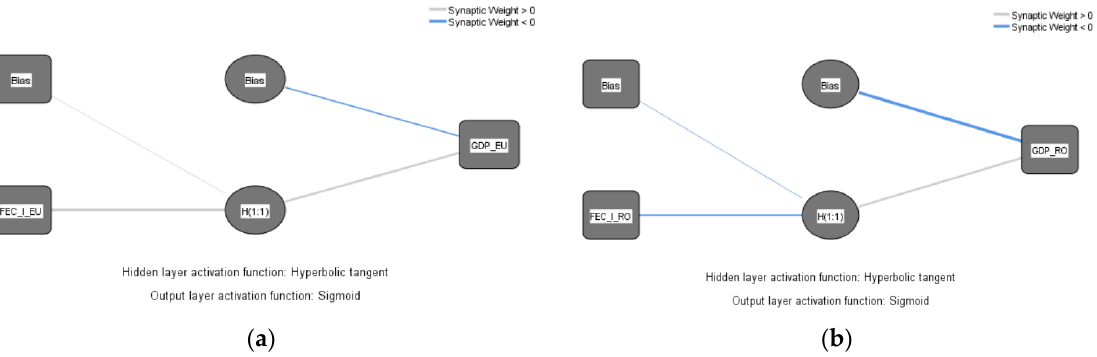
Figure 12. MLP network for identifying the influences of FEC_H on GDP: ( a ) EU; ( b ) RO. The relationships between final consumption for the industry sector (FEC_I) and GDP resulting from the construction of MLP neural networks with a single hidden layer (represented by the increase in energy efficiency) are shown in Figure 13 (EU (a) and RO (b)).